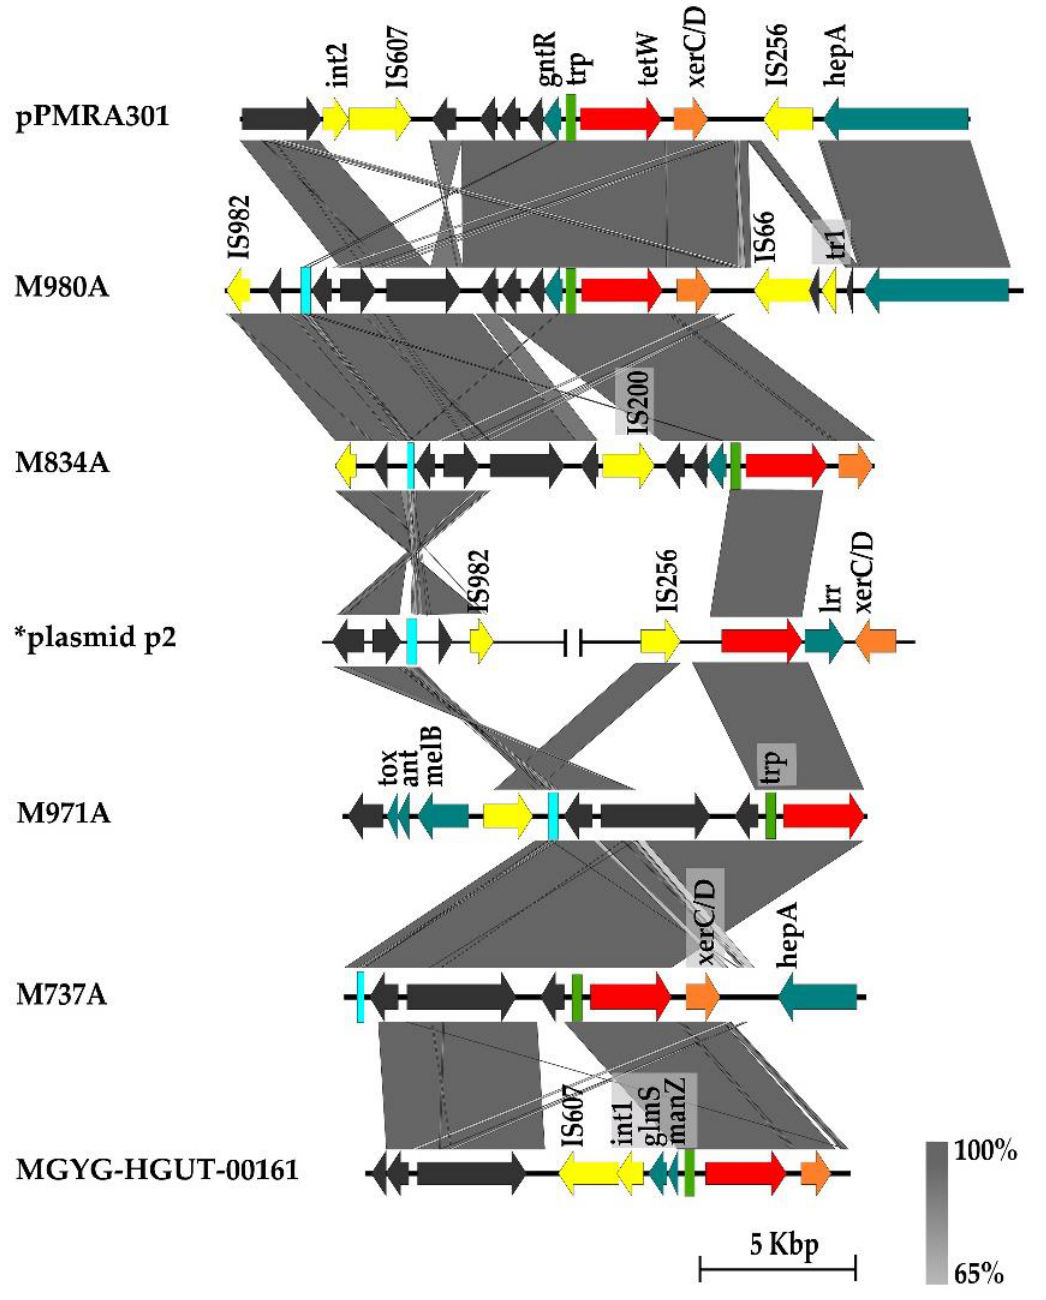
Figure 2. Organization of CDS in the contigs harboring tetW and xerC/D in L. amylovorus strains and comparison with plasmid pPMRA301 and plasmid p2 from L. amylovorus PMRA3 and GLR1118, respectively. Yellow arrow — CDS associated with mobility (e.g., IS — transposase, tr — putative transposase, int — putative integrase), red arrow — tetW gene, teal arrow — CDS with COG/PROKKA annotation, gray arrow — hypothetical protein, orange — XerC/D site-specific recombinase, green rectangle — tetW regulatory protein ( trp ), light blue — unknown misc. feature. The gray zones between sequences represent blastn sequence identity. *Plasmid p2 from GLR1118 shown only CDS identical to contigs bearing tetW resistance.